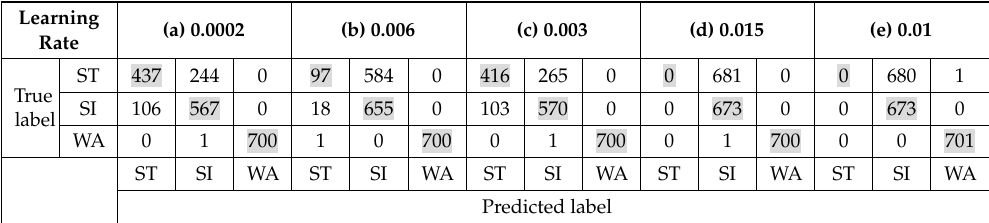
Table 7. Confusion matrices: (OR + LA1)—100-feature vector dataset.